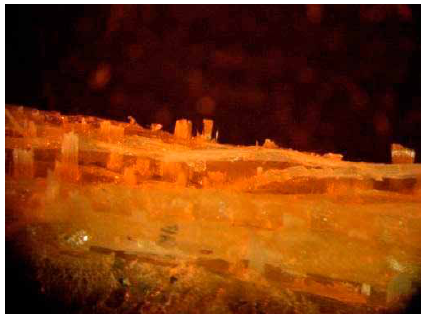
Fig. 5. A macro photo of a fragment of the destroyed sample portion